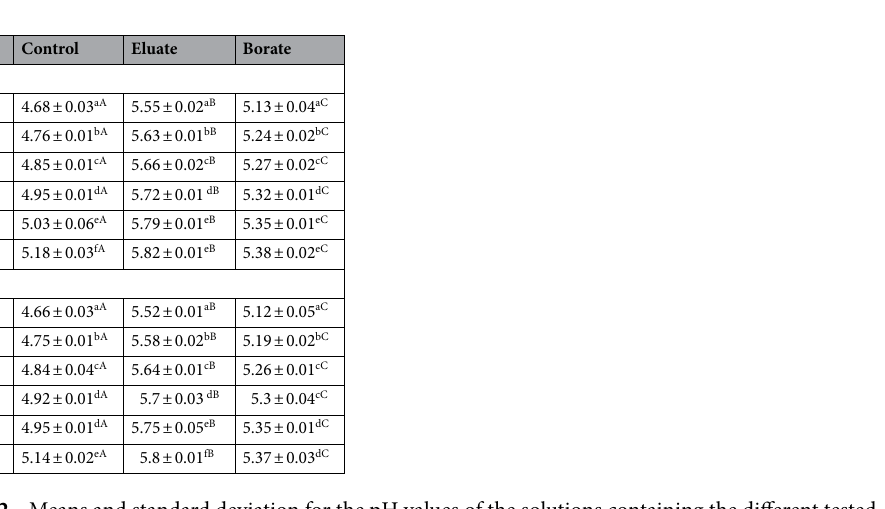
Table 2. Means and standard deviation for the pH values of the solutions containing the different tested groups (A) Dentin, (B) Enamel. Different superscript uppercase letters indicate significant difference within each row, and lowercase letters indicate significant difference within each column (p <